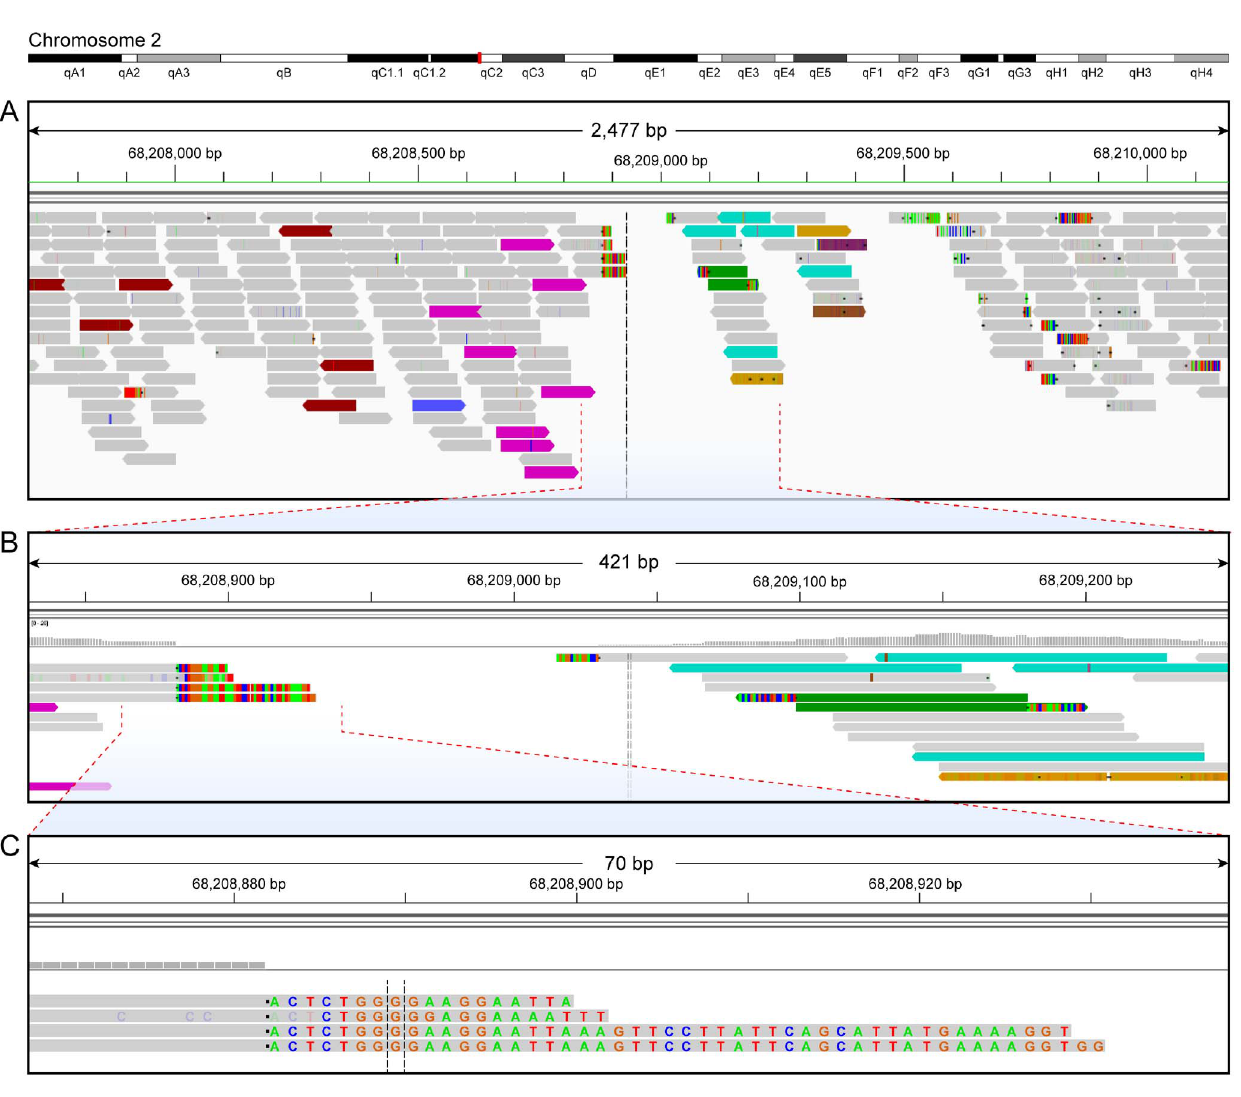
Figure 3. Read alignments around the insertion site of pmel-1. An ideogram of chromosome 2 is shown at the top with the red bar indicating the area of insertion. Gray bars represent concordant read pairs. Red and blue colors represent read pairs where the insert size is larger than expected (deletion) or smaller than expected (insertion), respectively. Discordantly mapped reads are coded by the chromosome on which their mates can be found, so reads represented by magenta and aquamarine rectangles have mates that mapped to chromosomes 6 and 14, respectively. Other colors represent genomic ‘‘noise’’. Multicolored blocks represent misaligned areas within reads. Soft-clipped reads were represented by grey bar with multicolored blocks at the ends. Misaligned bases in soft-clipped reads are shown in blue (C), green (A), red (T) and orange (G) color, respectively. ( A ) A snap shot of pmel-1 sequence reads aligned to the reference mouse genome near the integration area. Eight magenta-colored discordant reads are on the left side and five aquamarine-colored are on the right side. ( B ) An enlarged view of pmel-1 sequence reads, which shows five soft-clipped reads, one on right side, four on left sides of the insertion area. ( C ) A nucleotide level view of pmel-1 reads near the insertion area. This panel shows four soft-clipped reads that mapped partially to the b chain on chromosome 6 and partially to chromosome 2 of the reference